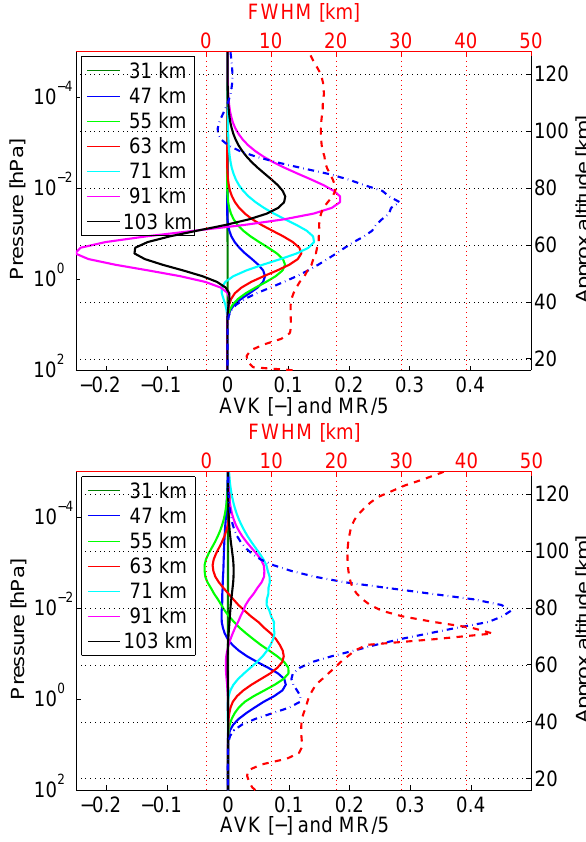
Fig. 4. Solid lines show the averaging kernels from 27 Decem- ber 2005 in vmr (a) and fractional (b) units for different altitudes. The blue dash-dotted line is the measurement response divided by 5. The red dashed line shows the FWHM of the averaging kernels.